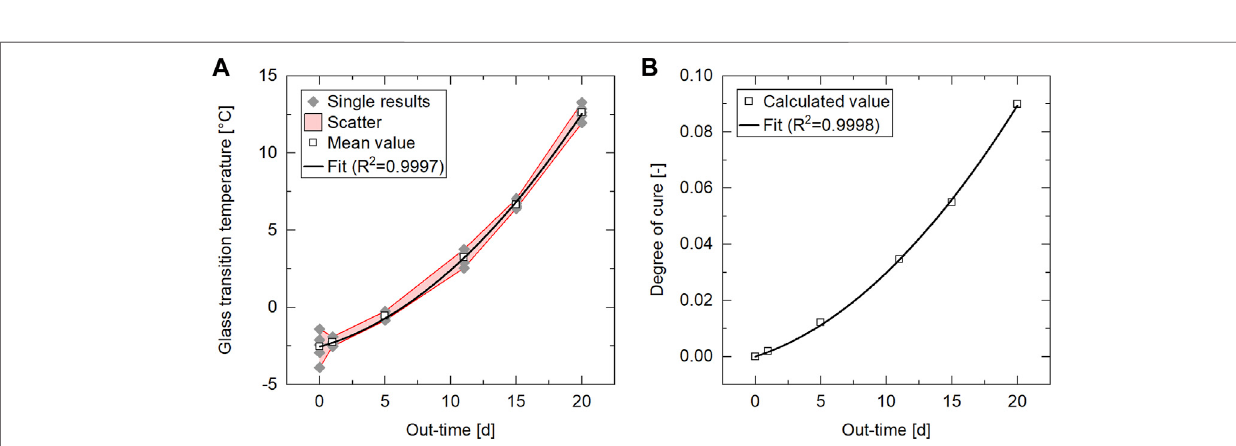
FIGURE 6 | Cure-related properties as a function of out-time from DSC runs at 10 K/min (Material: IM7/8552 prepreg; out-time: 1 day 20 days at T (cid:1) 21 ° C , RH (cid:1) 40 % ). (A) Glass transition temperature. (B) Degree of cure.